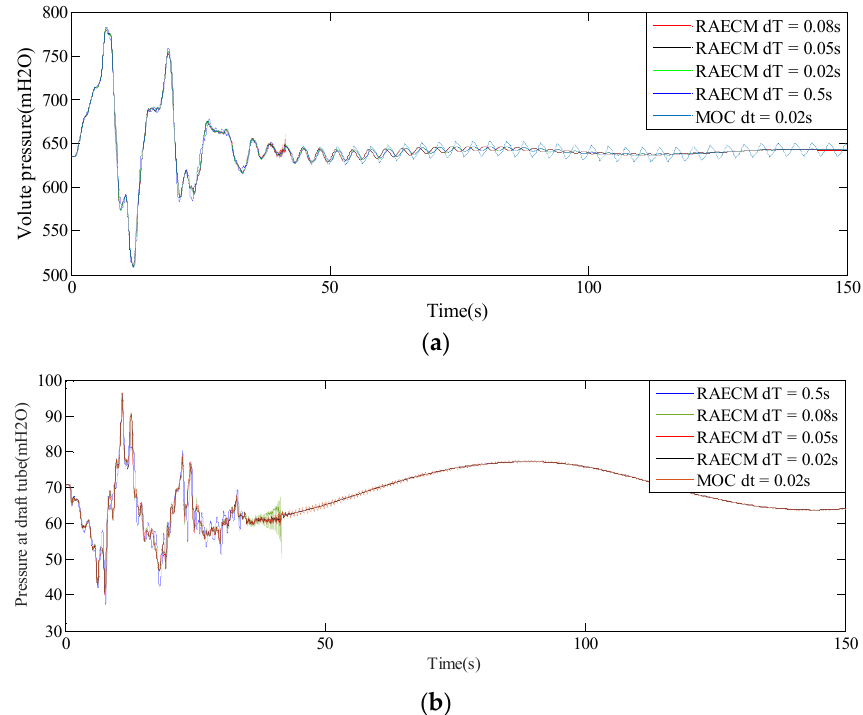
Figure 7. The comparison of the equivalent circuit model with variable space-step via correctional error compensation with MOC: ( a ) volute pressure; ( b ) pressure at draft tube.